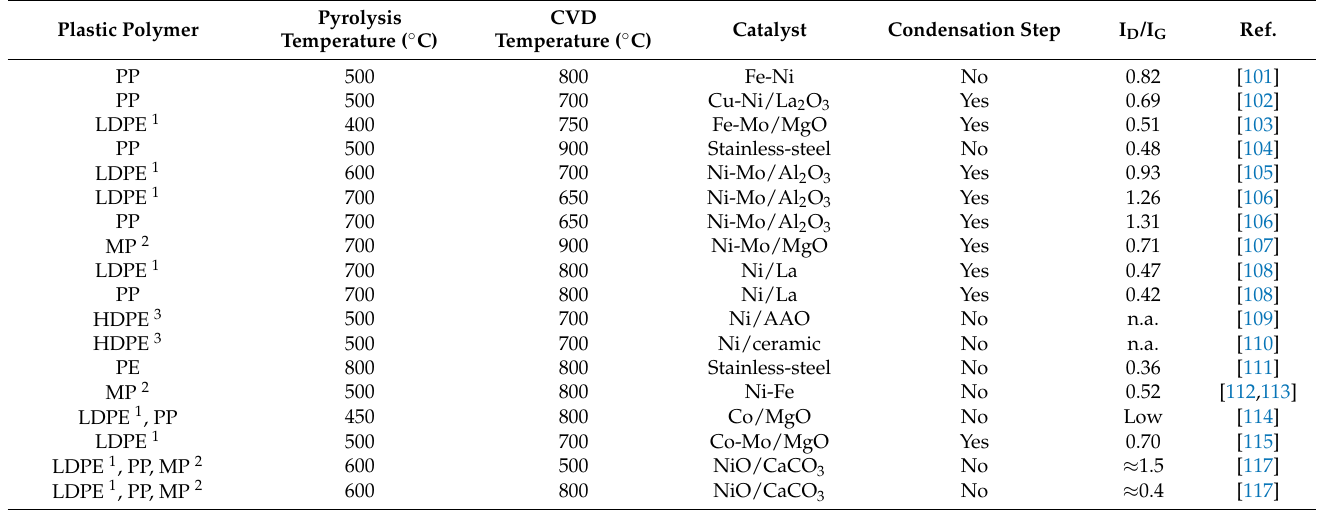
Table 3. Recently reported processes for the CVD formation of CNTs from plastic